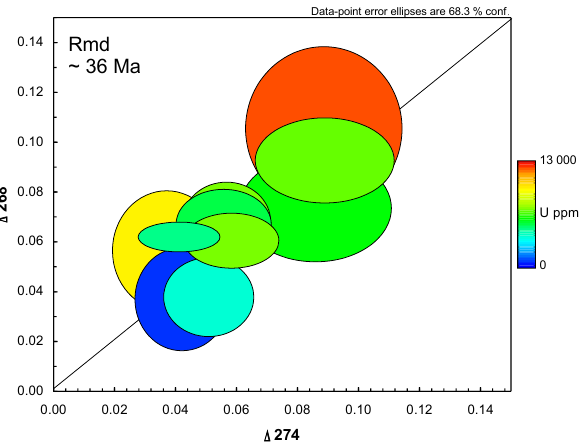
Figure 8. (cid:49) 272 vs. (cid:49) 274 plot for randomly oriented baddeleyite, with predicted trends for unreactive molecule ejection shown. Note that unreacted molecule ejection well in excess of 10% is required to explain isotopologue deviations of this magnitude.